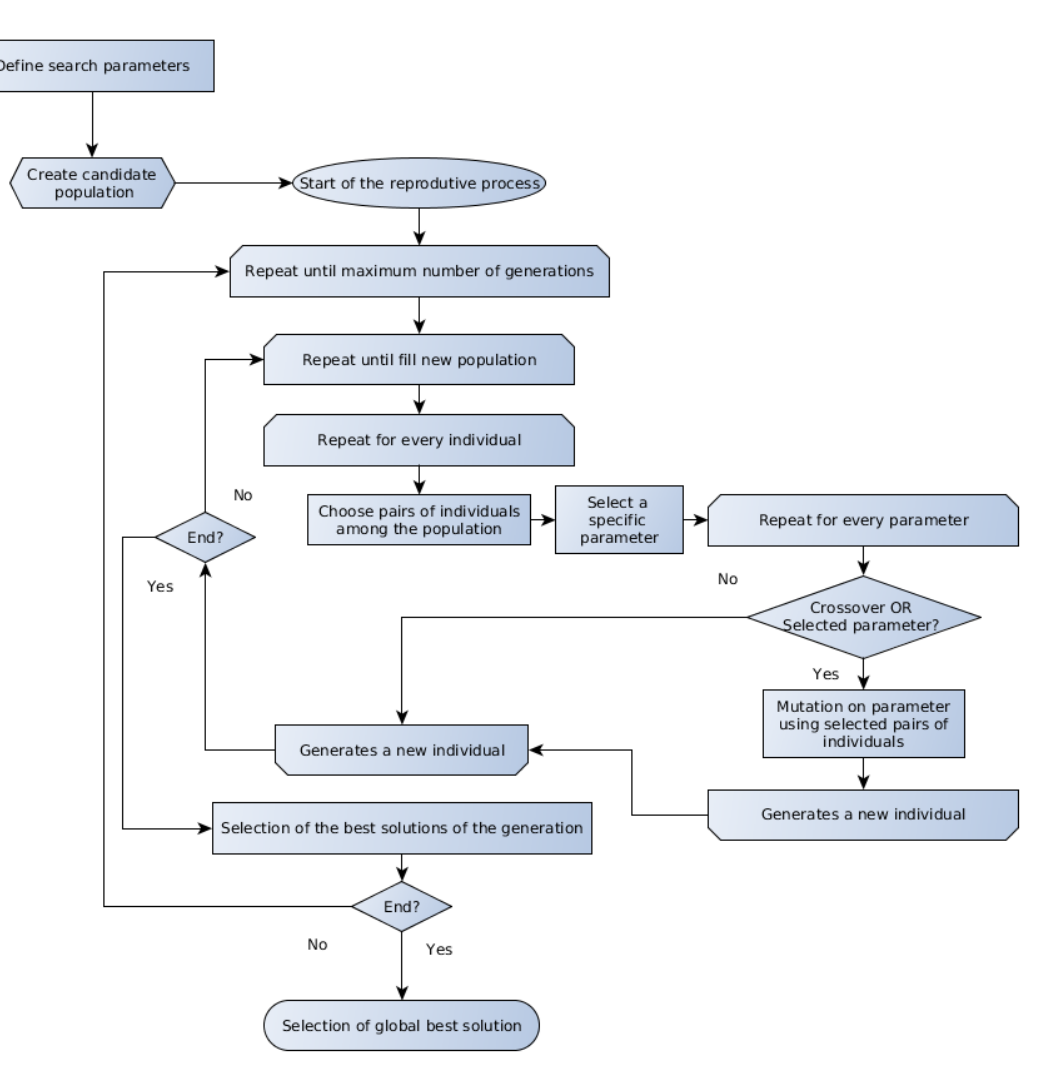
Figure 2. Schematic representation of the DE